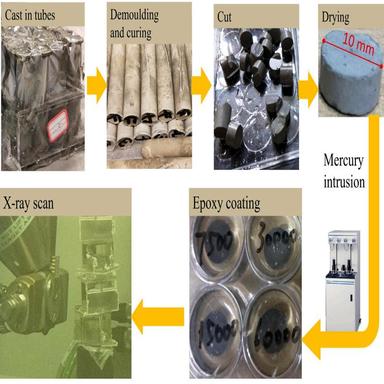
Sequences of sample preparation for MIP and X-CT tests.